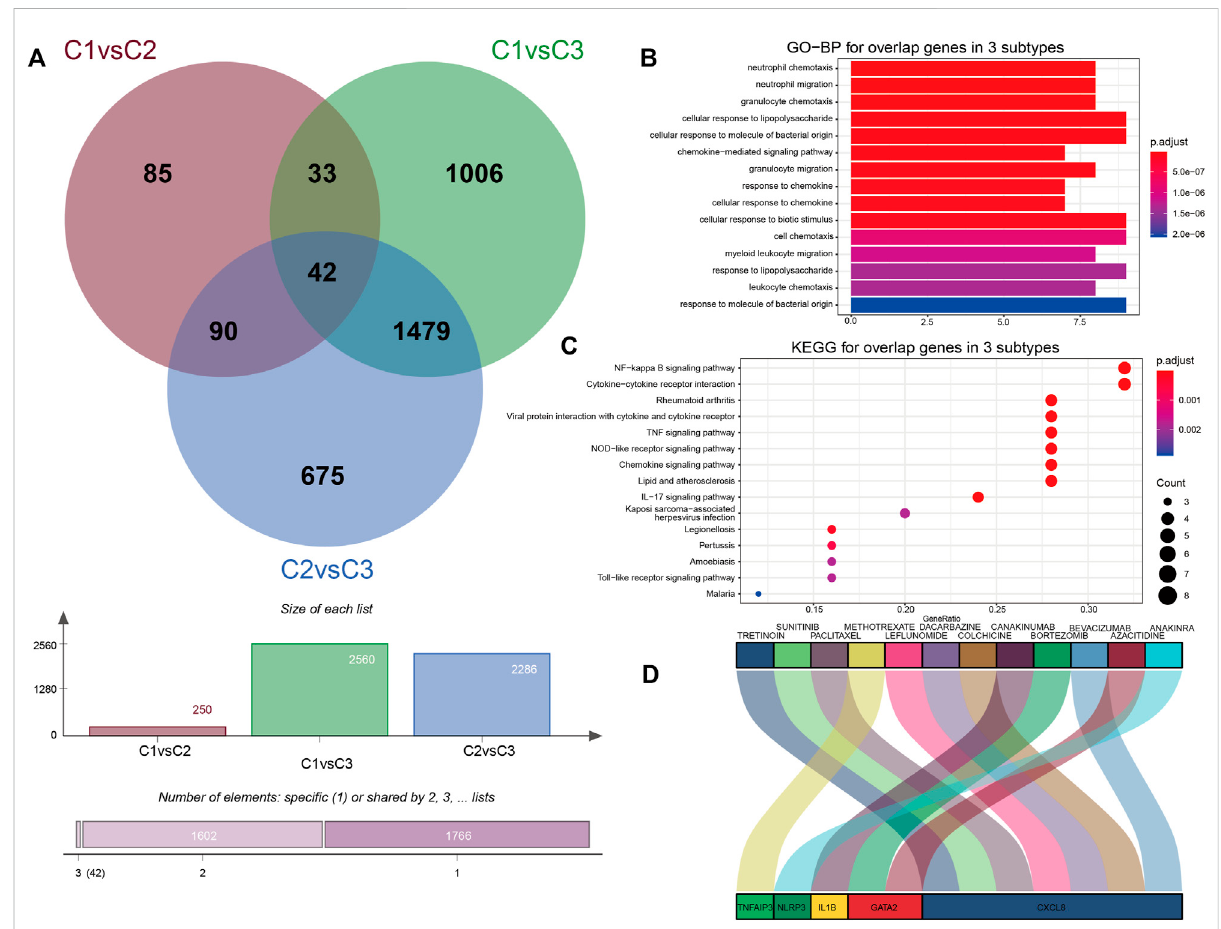
FIGURE 7 Biological characteristics and potential drugs of three PRG modi fi cation patterns. (A) Forty-two common genes were identi fi ed as genes associated with the pyroptosis phenotype. (B) Barplot graph for GO enrichment (the longer bar means the more genes enriched, and the increasing depth of red means the differences were more obvious). (C) Bubble graph for KEGG pathways (the bigger bubble means the more genes enriched, and the increasing depth of red means the differences were more obvious; q-value: adjusted p -value). (D) Sankey diagram showing 42 genes predicted by DGIdb for potential